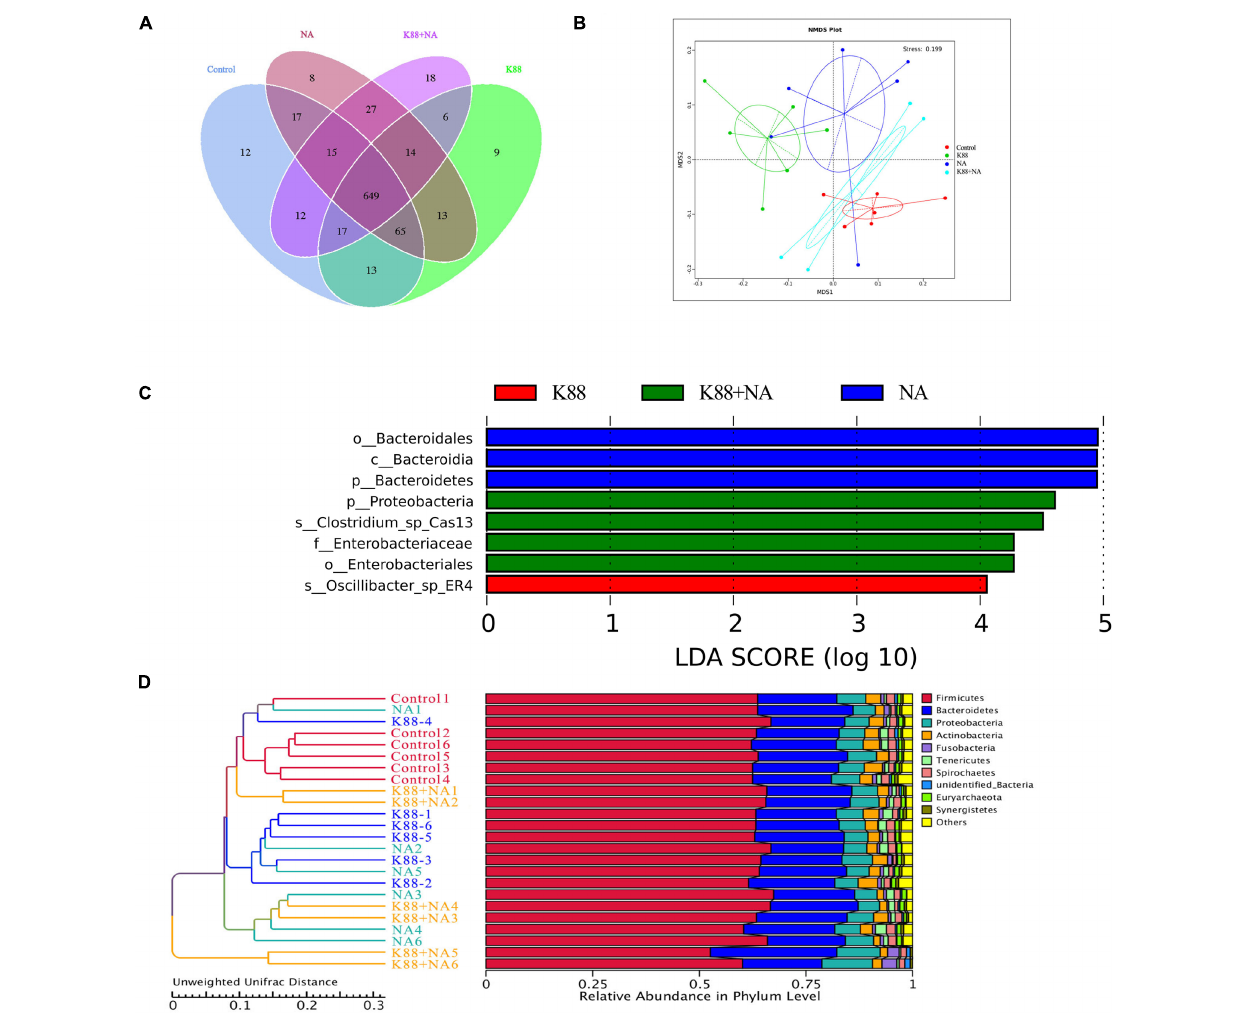
FIGURE 4 | Nicotinic acid improved the bacterial community caused by E. coli infection in colonic contents of weaned piglets. The bacterial communities in the colonic contents of weaned piglets were investigated using Illumina sequencing of the 16S rRNA gene. Venn diagram shows the common and special OTUs distribution among the four groups (A) , non-metric multidimensional scaling (NMDS) based on operational taxonomic unit levels (B) , the LDA score analysis (LDA score ≥ 4) in four groups (C) , UPGMA Clustering was conducted based on Unweighted Unifrac distance (D) .